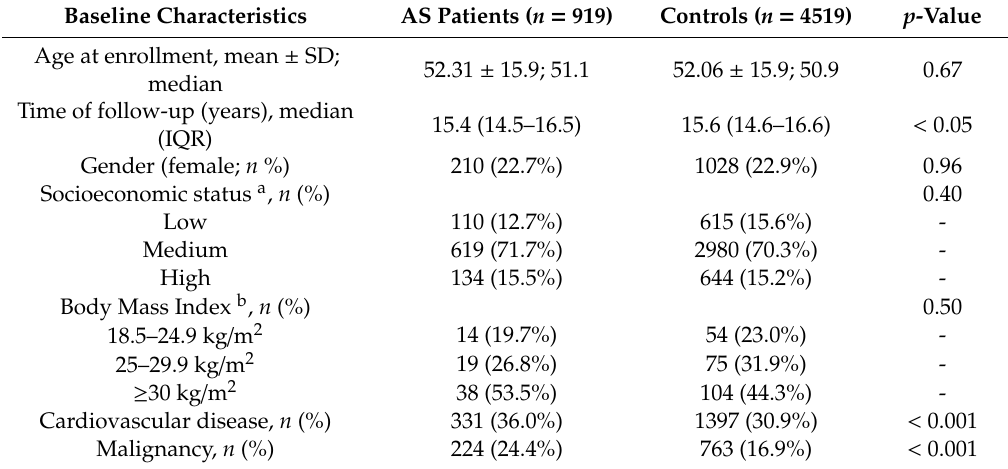
Table 1. Baseline characteristics of the study population.